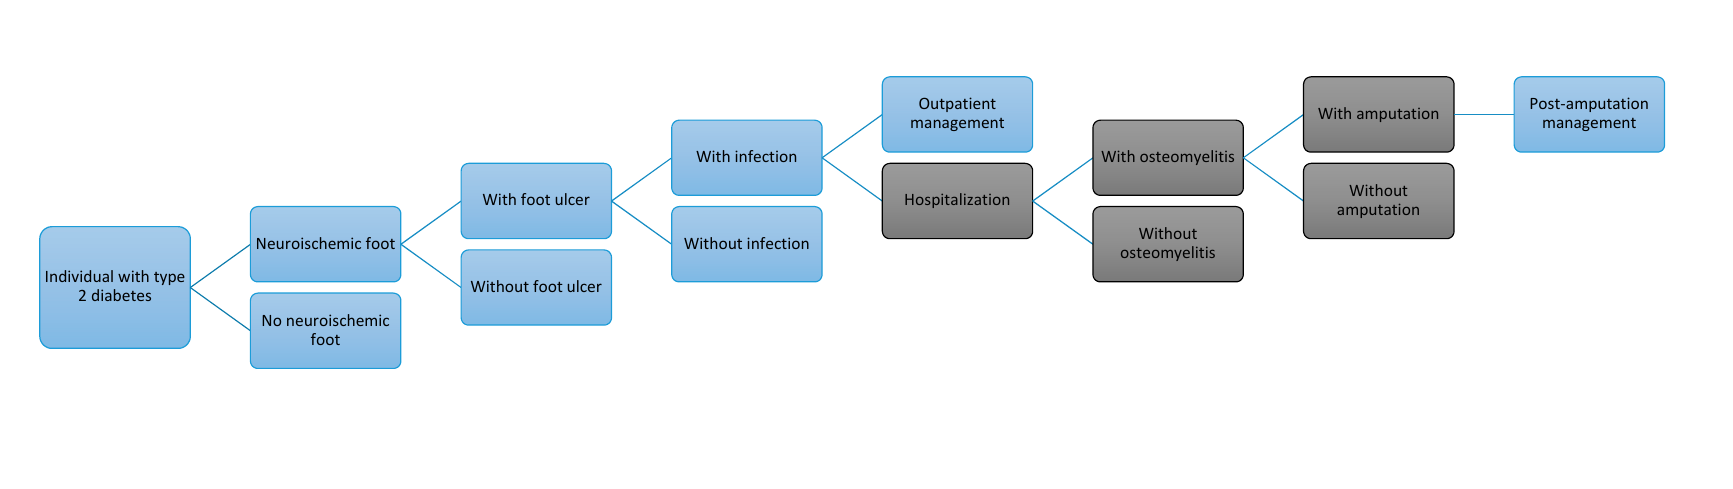
Figure 1. Decision tree diagram for patients with Diabetic Foot Disease and related outcomes. Note: In blue conditions managed in the outpatient setting and in dark grey conditions managed as inpatients.